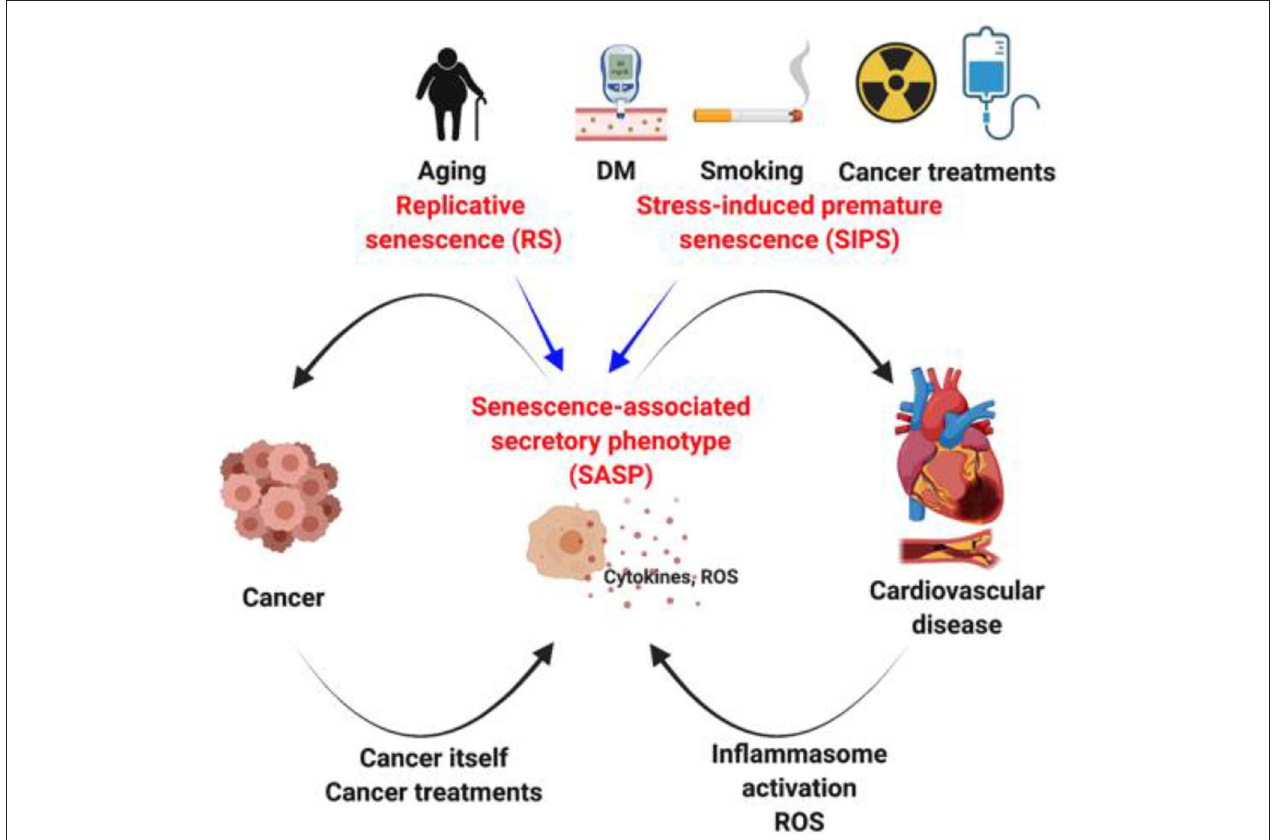
FIGURE 3 | SASP as a hinge between cancer and cardiovascular disease. DM, Diabetes mellitus.